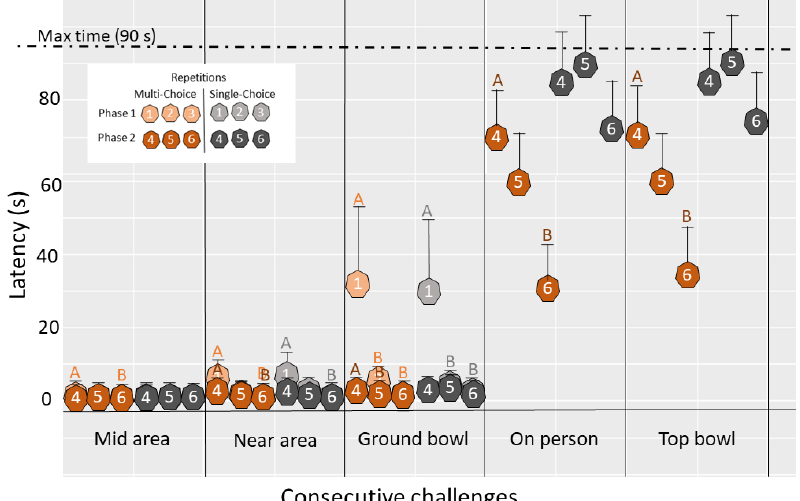
Figure 4. The approach dynamics in the repeated opportunity test. Dot plot (estimated marginal mean and SEM) showing the approach dynamics with each repetition during the repeated opportunity test of chicks from “multi-choice” and “single-choice” treatments. The first phase (repetitions 1–3) involved one food bowl on the ground, while the second phase (repetitions 4–6) involved a person inside the pen, one food bowl on the ground and another in the lap of the person. Latencies to overcome the challenges are shown in seconds, to enter the mid area, to enter the near area, to peck in the ground food bowl, to jump up on the person where the top food bowl was located, and, finally, latency to peck in the top food bowl. Different letters (A,B; note also the different shades within each color) indicate significant differences between repetitions, i.e., improvements with repetition, within each treatment and the different phases of the test.